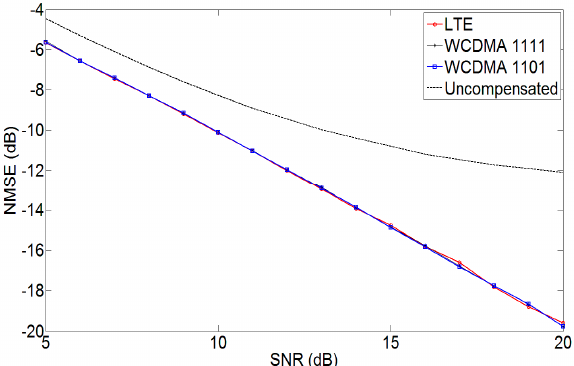
Figure 5. Normalized mean squared error (NMSE) vs. SNR using the proposed mitigation approach for g = g ’ = 0.92 dB and θ = θ ’ = − 6 degrees.